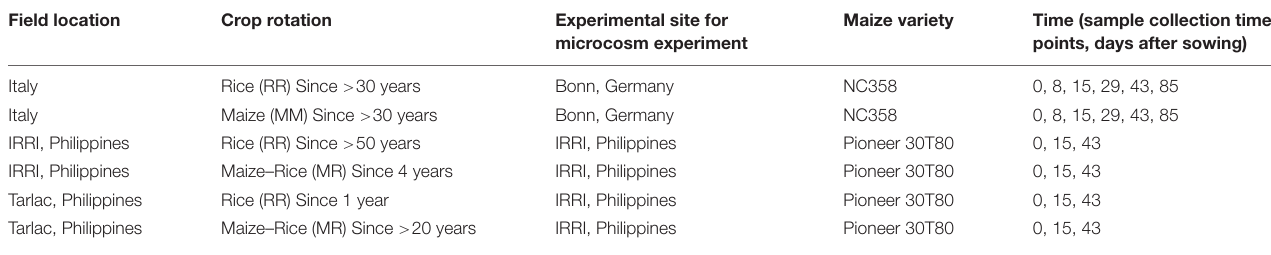
TABLE 1 | Experimental setup of the microcosm